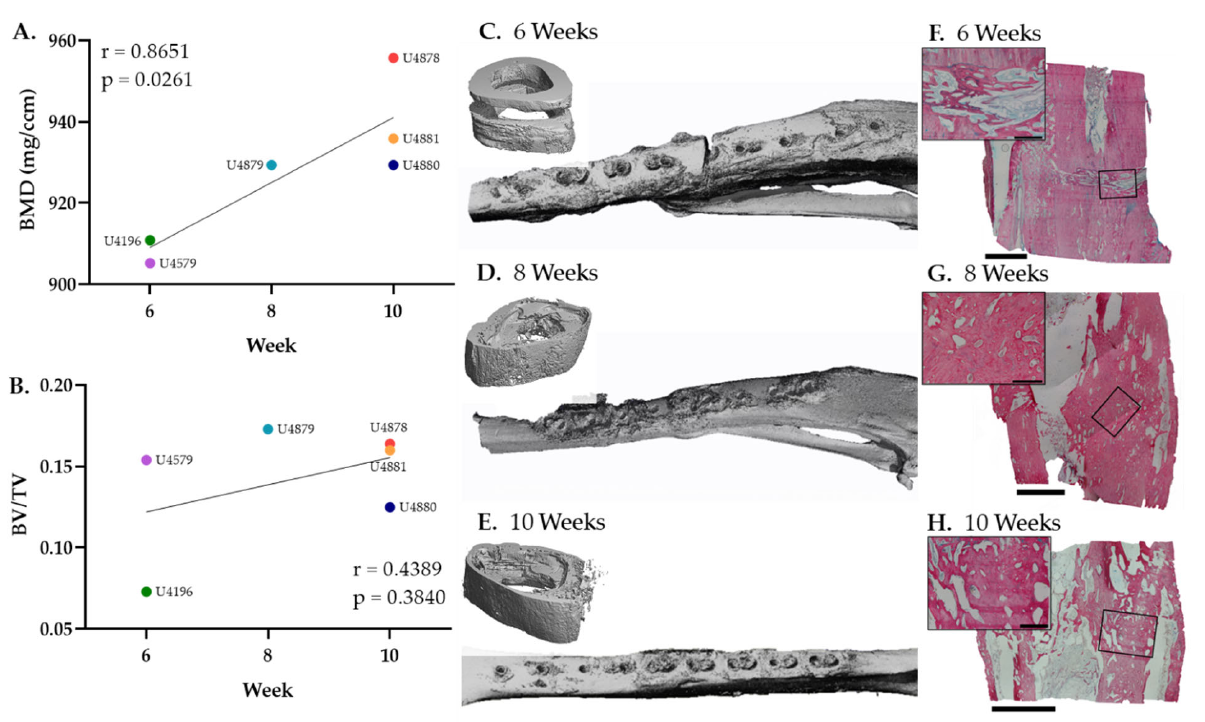
Figure 4. Quantitative bone mineral density (BMD) and bone volume (BV) consistently increase during bone repair. ( A ) BMD and ( B ) BV/TV measurements of individual animals at necropsy with corresponding correlation coefficients (r) and p ‐ values ( p ). ( C – E ) Representative μ CT images at 6 ‐ , 8 ‐ , and 10 ‐ week necropsy. ( F – H *) Representative HBQ stained histology images at 6 ‐ , 8 ‐ , and 10 ‐ week necropsy. * Scale bars are 500 (inset) and 2500 μ m (bottom).